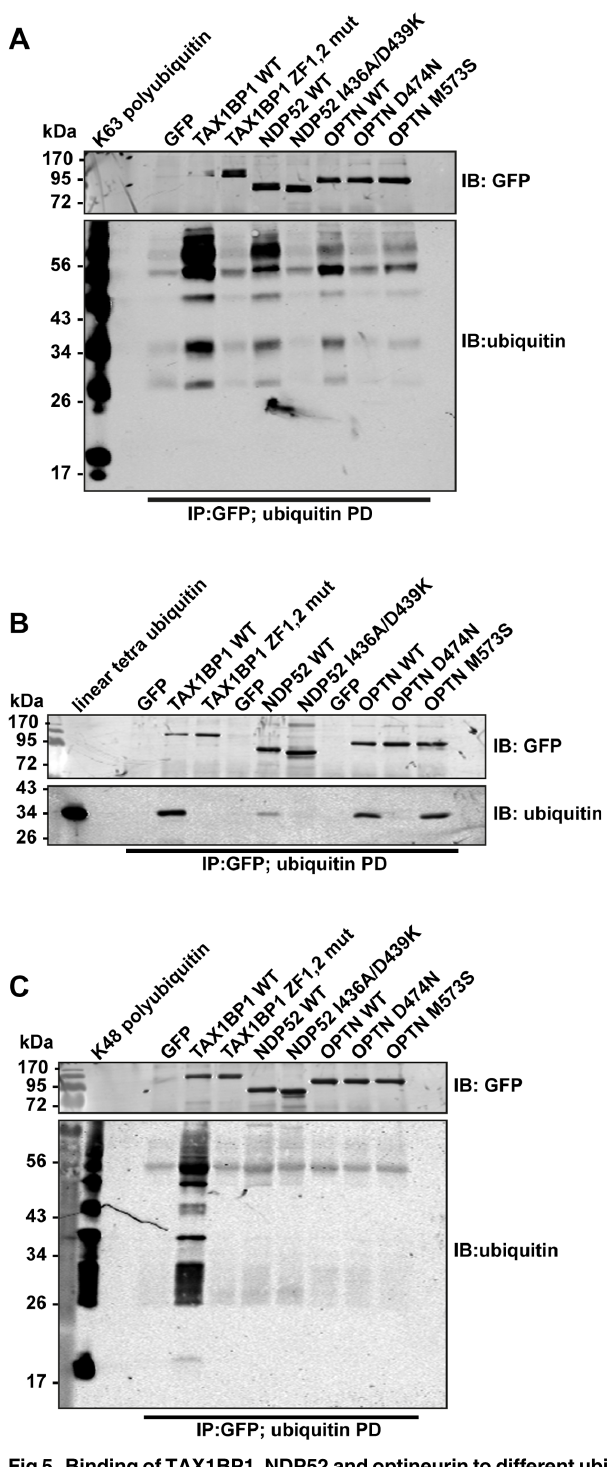
Fig 5. Binding of TAX1BP1, NDP52 and optineurin to different ubiquitin chain types. GFP immunoprecipitation followed by either K63-linked polyubiquitin (A), linear tetra-ubiquitin (B), or K48-linked polyubiquitin (C) pull-downs (PD) from RPE cells transfected with GFP alone, GFP-TAX1BP1, GFP-NDP52, or GFP-optineurin wild-type and mutants. Western blot analysis performed using antibodies specific for ubiquitin and